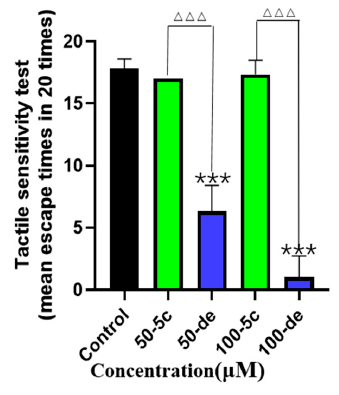
Figure 12. Effects of compound 5c and donepezil on tactile sensitivity. The 4 hpf zebrafish embryos were exposed to compound 5c and donepezil separately at 50 and 100 μ M until 96 hpf, and tactile sensitivity was tested. *** p < 0.001 vs. control group; △△△ p < 0.001 compound 5c group vs. donepezil group.